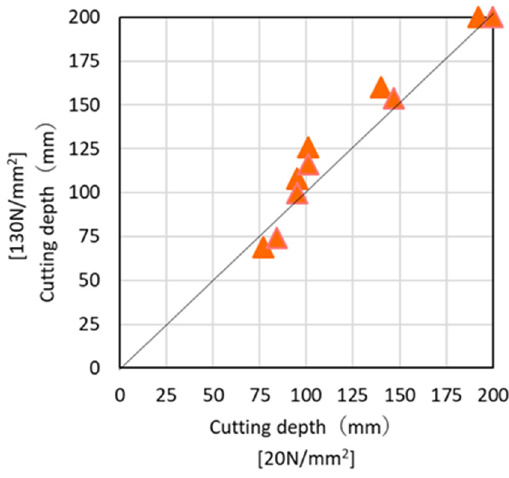
Figure 6. Correlation between cutting depth and concrete strength (laser 9 kW).